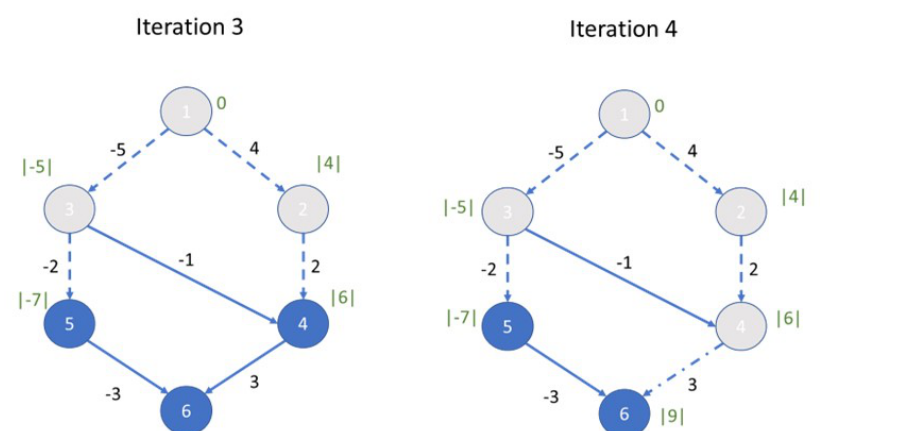
Figure 1. A simple example of two iterations of CHa .